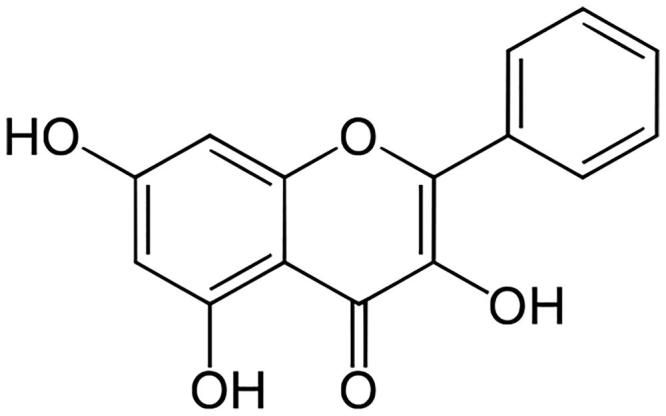
Galangin structure.